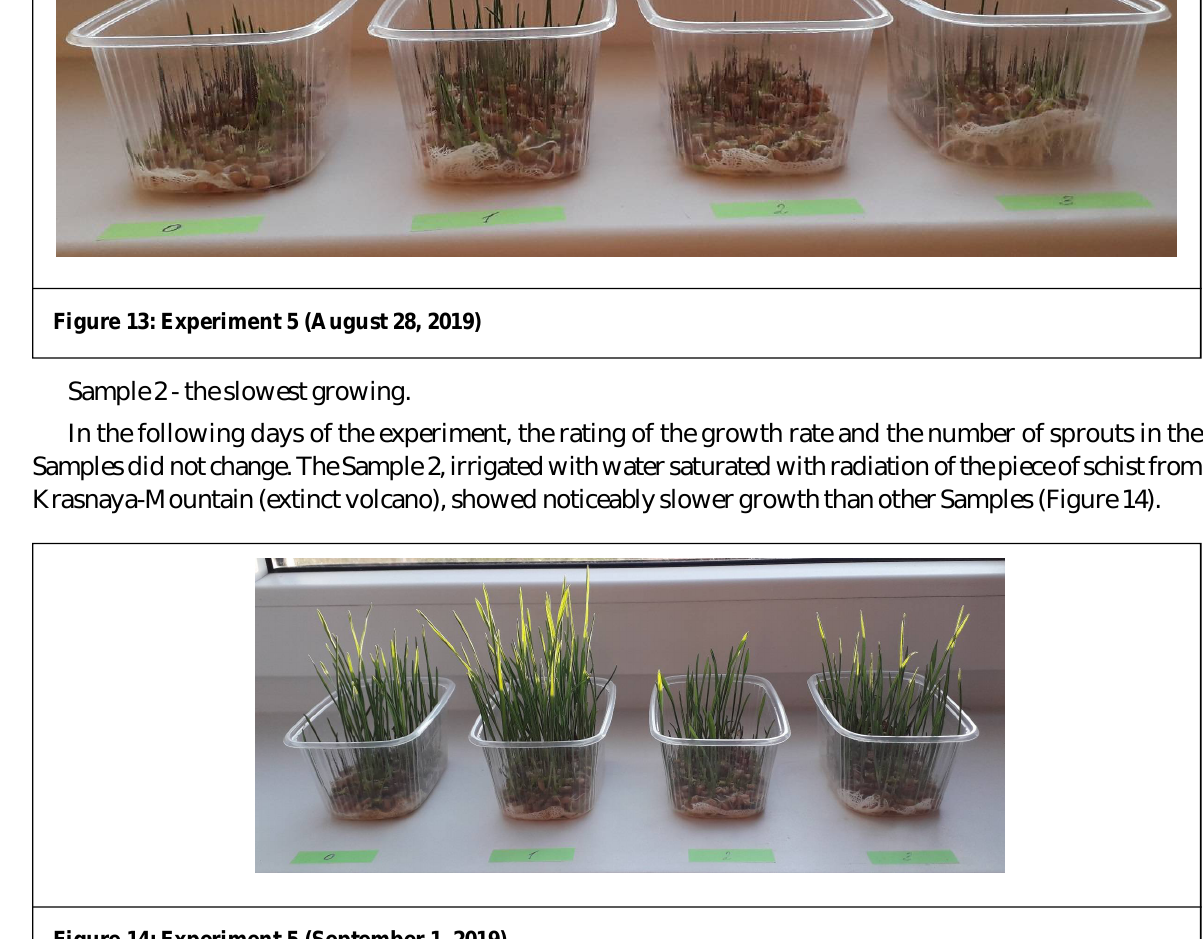
Figure 14: Experiment 5 (September 1,